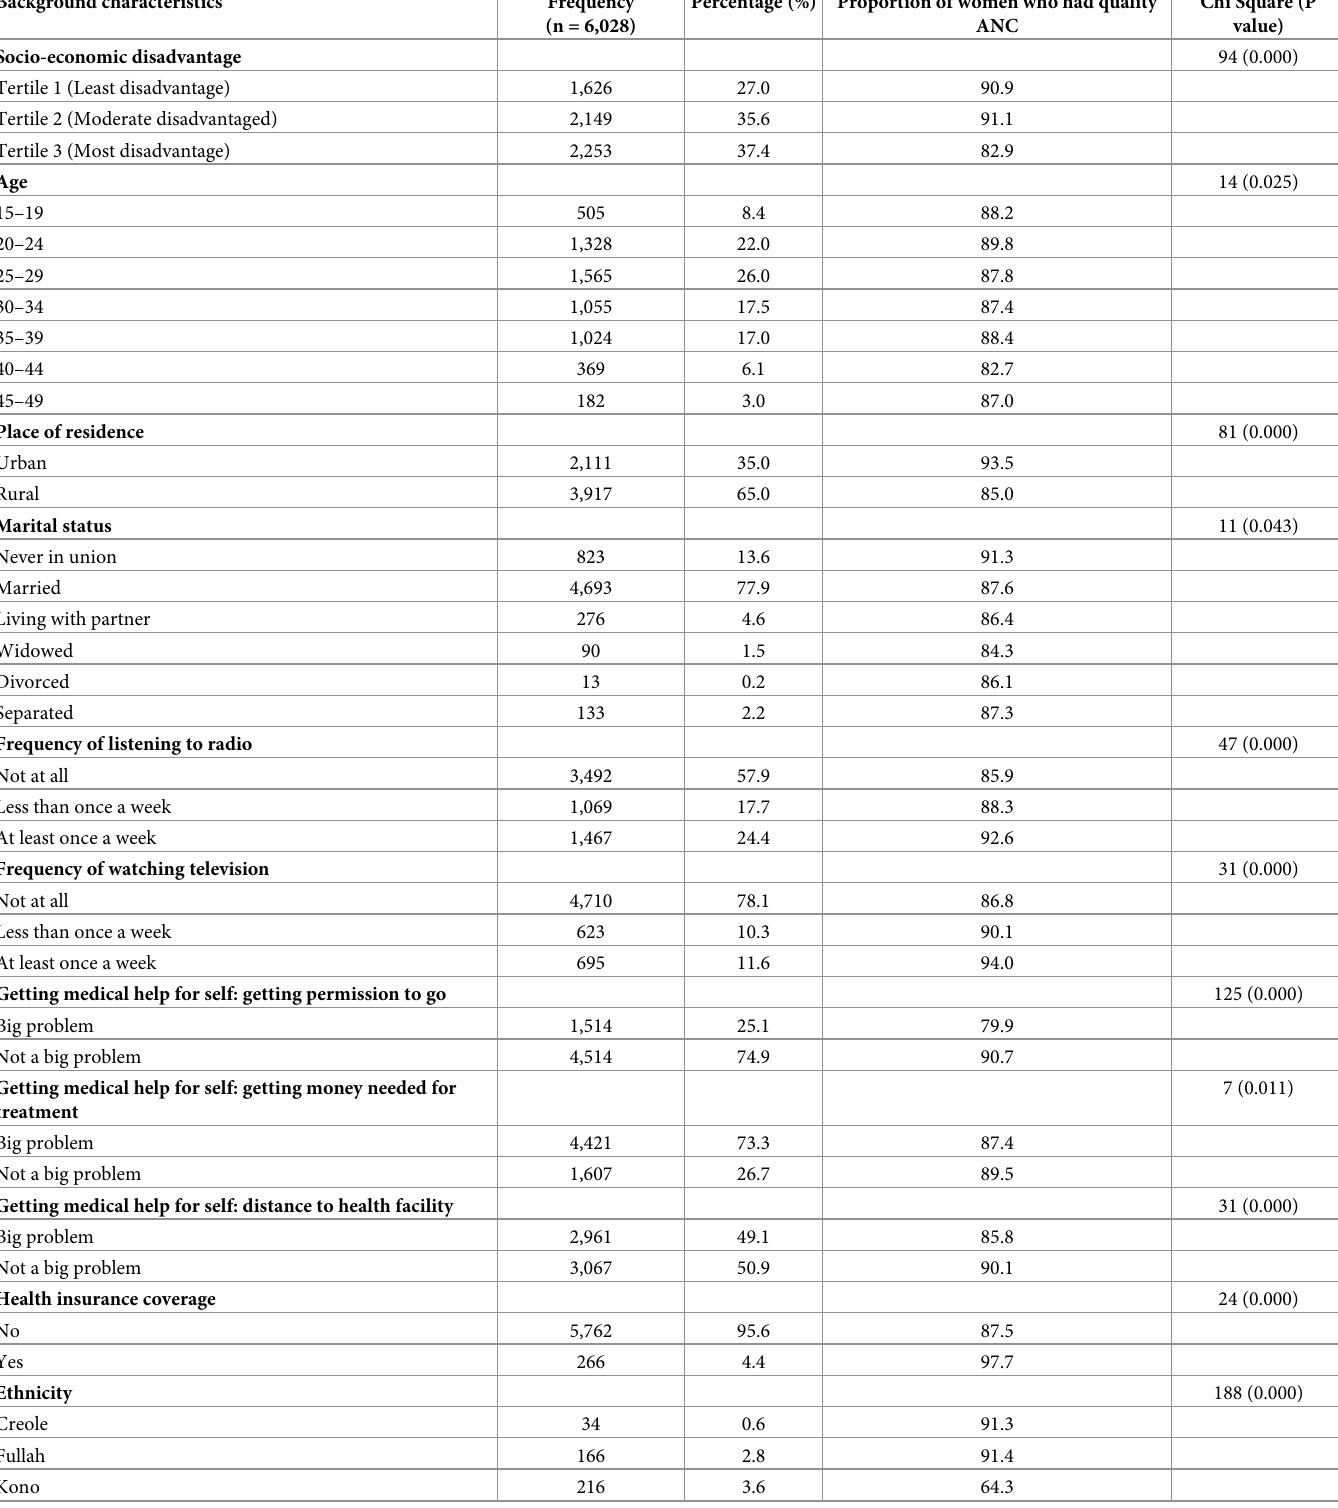
Table 2. Background characteristics and proportion of quality antenatal care